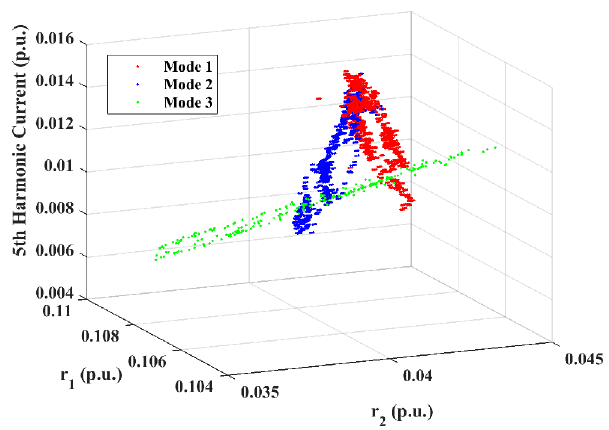
Figure 6. Clustering results of case 2. Table 3. The estimated values of the simplified model parameters of case 2.